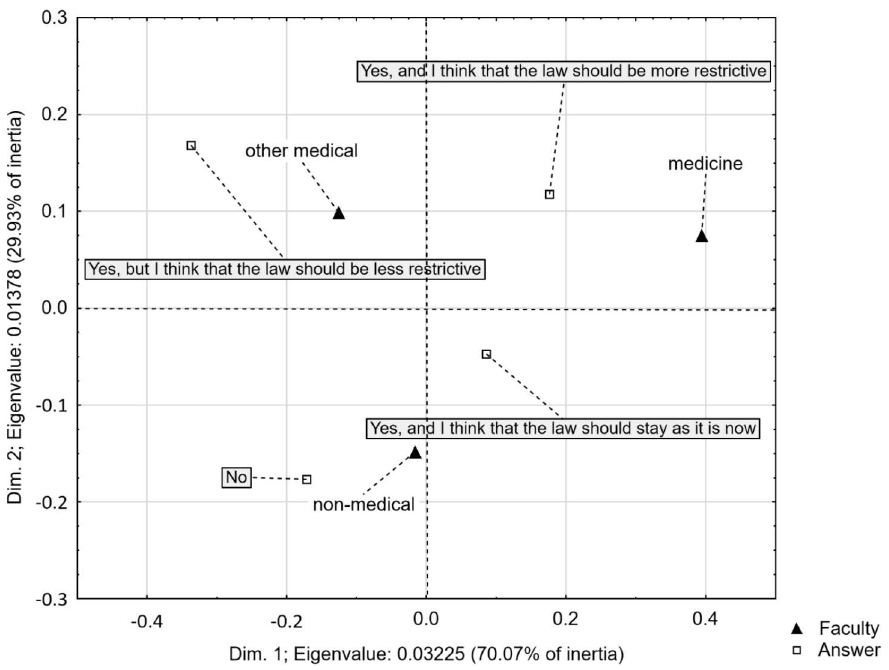
Figure 2. Correspondence map: faculty vs. answer to the question: Should wearing masks be